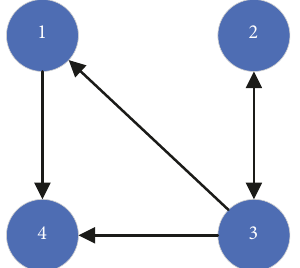
Figure 1: The communication topology with mode 1. Figure 2: The communication topology with mode 2.